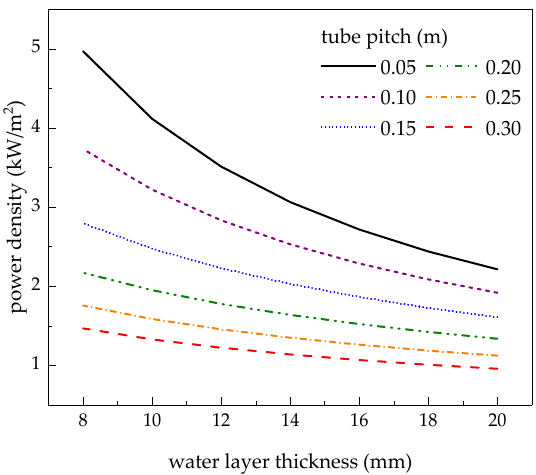
Figure 8. E ff ect of water layer thickness on heat exchange power density. (tube diameter = 10 mm).